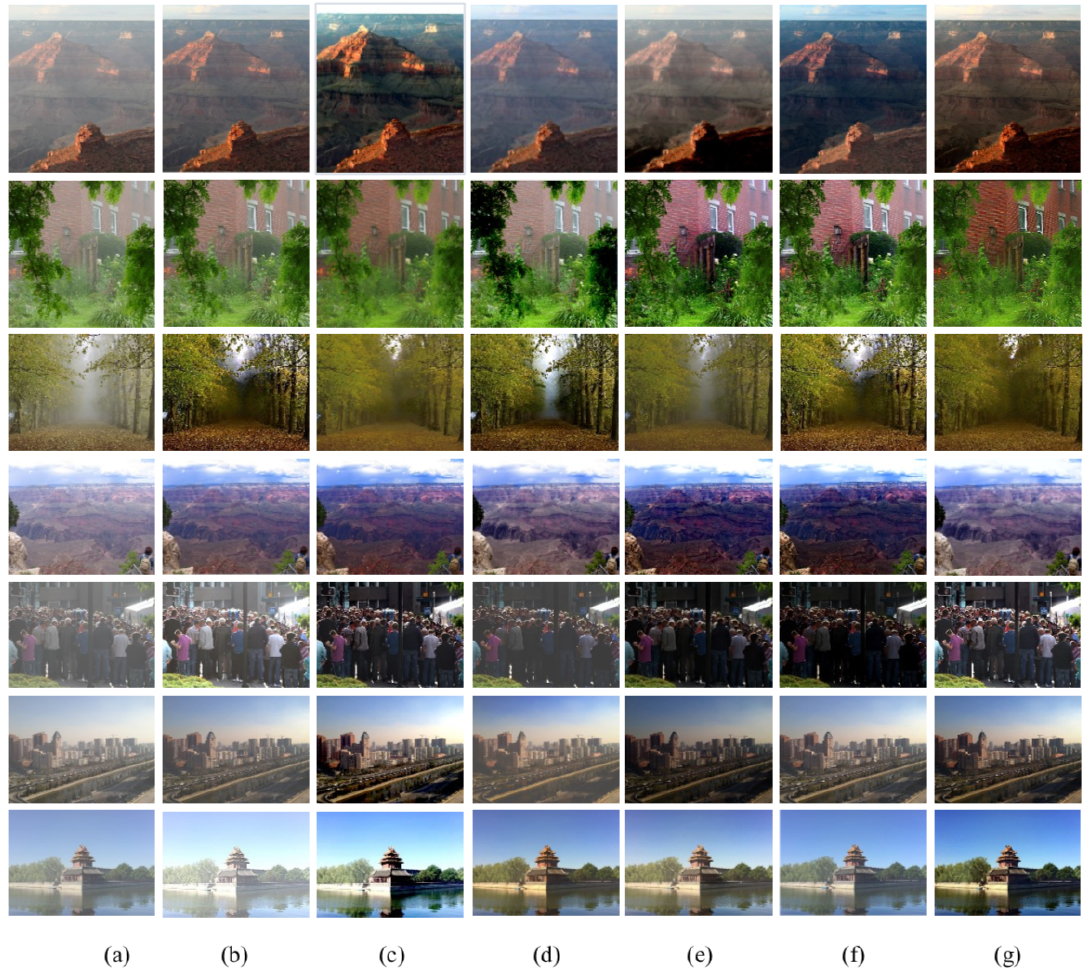
Figure 15. Samples of visual comparison of proposed system’s results with the comparative methods on real-world hazy images: ( a ) hazy image; ( b ) He’s method [14]; ( c ) Cai’s method [28]; ( d ) Ren’s method [26]; ( e ) Li’s method [40]; ( f ) Salazar’s method [35]; and ( g ) our